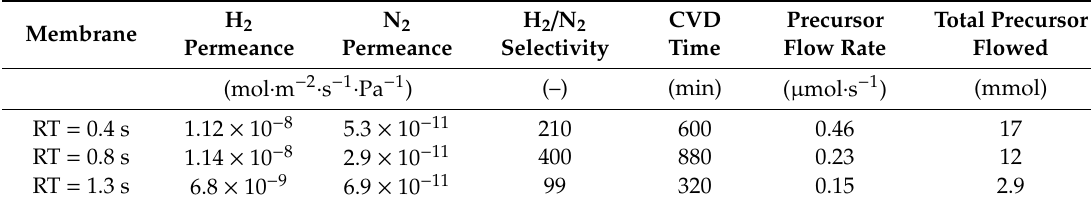
Table 2. Summary of the membrane performance at 300 °C, and deposition conditions of the MTMOS- derived membranes deposited with residence times of 0.4 s, 0.8 s, and 1.3 s.